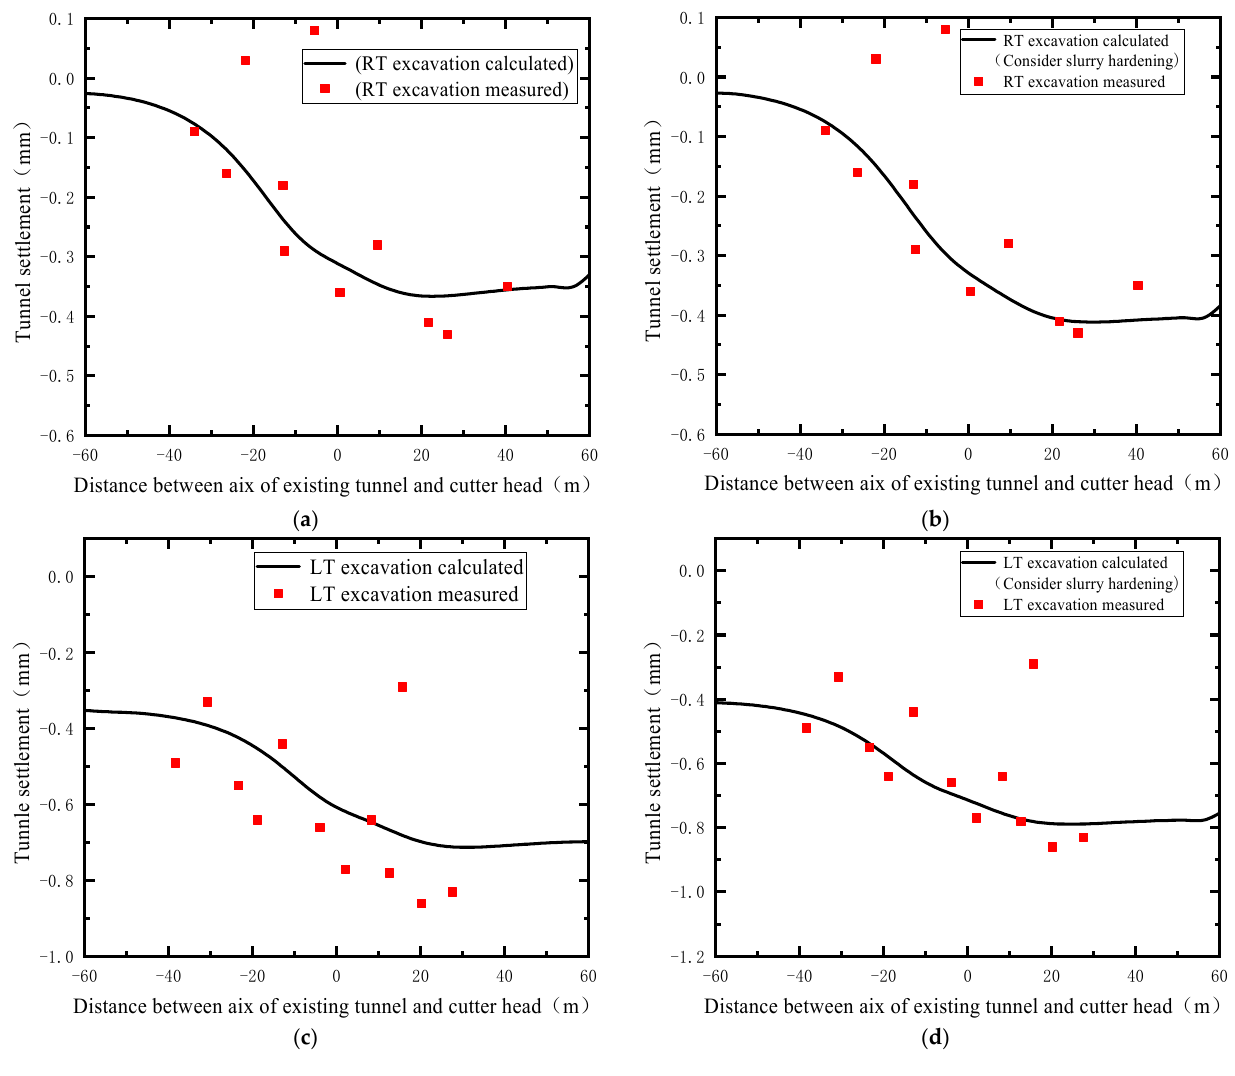
Figure 8. Line 3 excavation of the existing tunnel vault settlement calculated values compared with measured values: ( a ) RT excavation process; ( b ) RT excavation process (considering slurry hardening); ( c ) LT excavation process; ( d ) LT excavation process (considering slurry hardening).